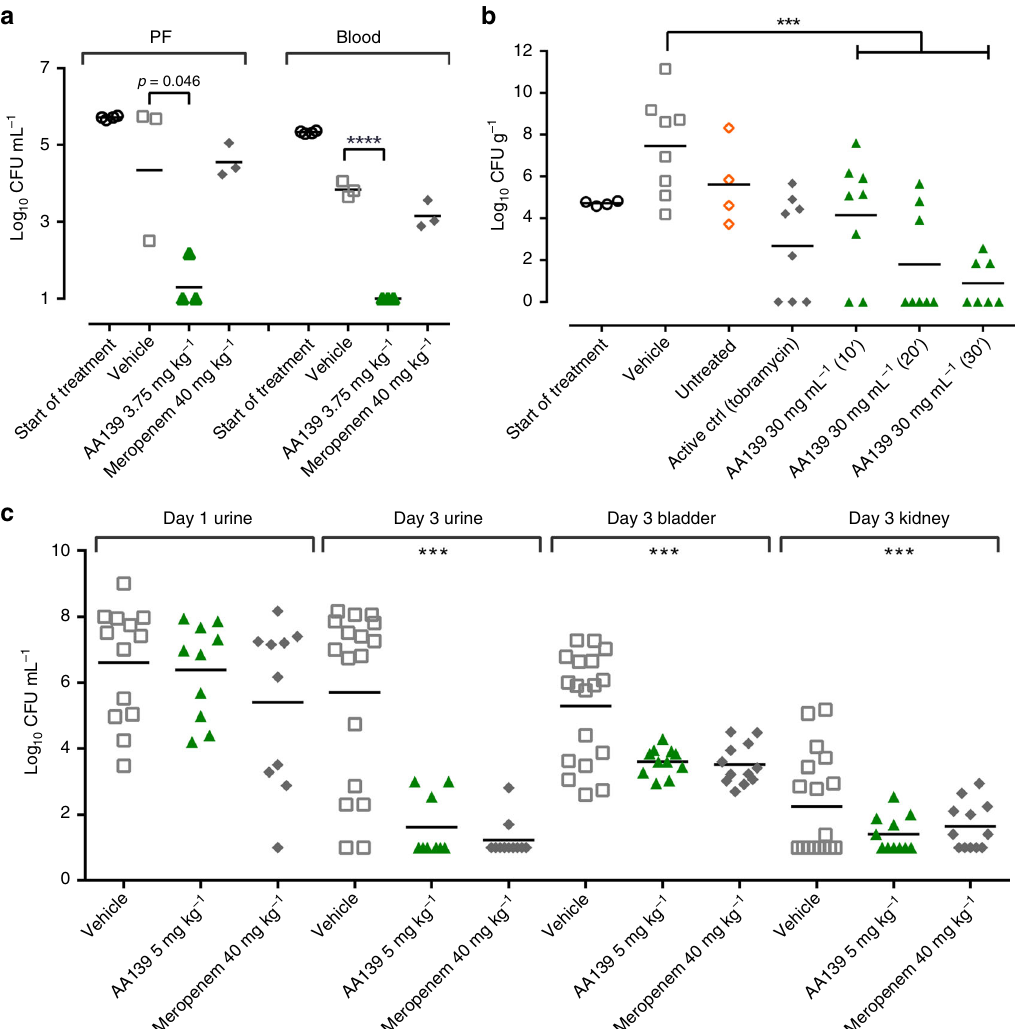
Fig. 5 In vivo peritonitis, pneumonia and UTI murine models for AA139. a Peritonitis model dosed at 3.75 mg kg − 1 against MDR E. coli AID#172 (inoculated in the lateral lower quadrant of the abdomen by single I.V dose) with CFU mL − 1 measured in the peritoneal fl uid (PF) and the blood after 5 h post infection ( n = 4 for start of treatment groups and n = 3 for other groups). b P. aeruginosa pneumonia model treated with aerosolized AA139 for 10, 20, or 30 min duration in an aerosol exposure chamber at 2, 12, and 24 h post infection. The bacterial load (CFU g − 1 lung tissue) was measured at 34 h post infection ( n = 4 for start of treatment group, n = 7 for AA139 30 min treatment group and n = 8 for other groups). c Bacterial load (CFU mL − 1 ) in the urine of UTI murine model infected with ESBL producing E. coli DSA 443 before treatment (day 1), and bacterial load (CFU mL − 1 ) in the urine, bladder, and kidney after last treatment (day 3). Animals were treated twice-daily with AA139 at 5 mg kg − 1 or meropenem at 40 mg kg − 1 i.v. ( n = 12). Horizontal bar indicates geometric mean burden of each treatment. Statistical comparison performed with Prism 8 using one-way ANOVA, Dunnett ’ s multiple comparisons test, and all differences between means with p ≤ 0.05 are indicated: *** p ≤ 0.001; **** p ≤ 0.0001. Source data are provided as a source data fi